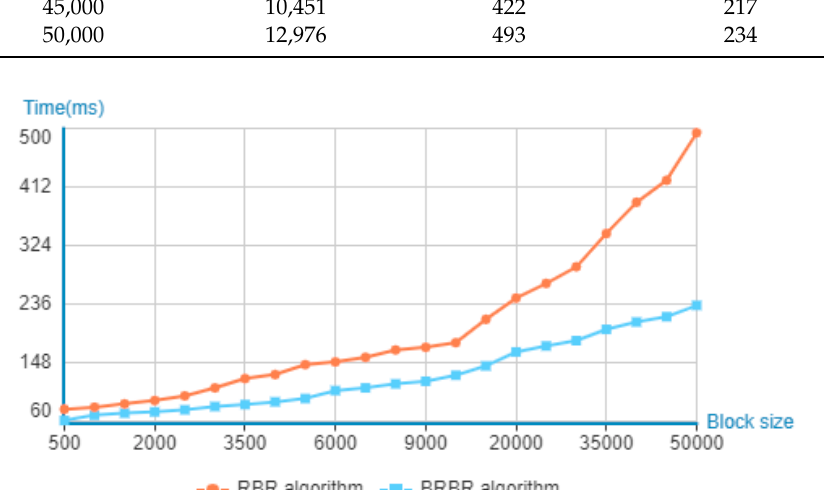
Figure 14. Comparison of retrieval efficiency of RBR and BRBR algorithms under different block sizes (number of transaction users = 2).